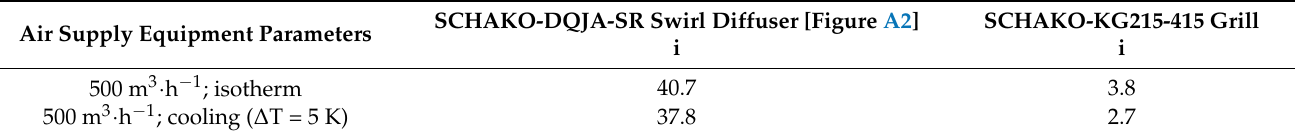
Table 2. Induction rates of swirl diffuser compared to a